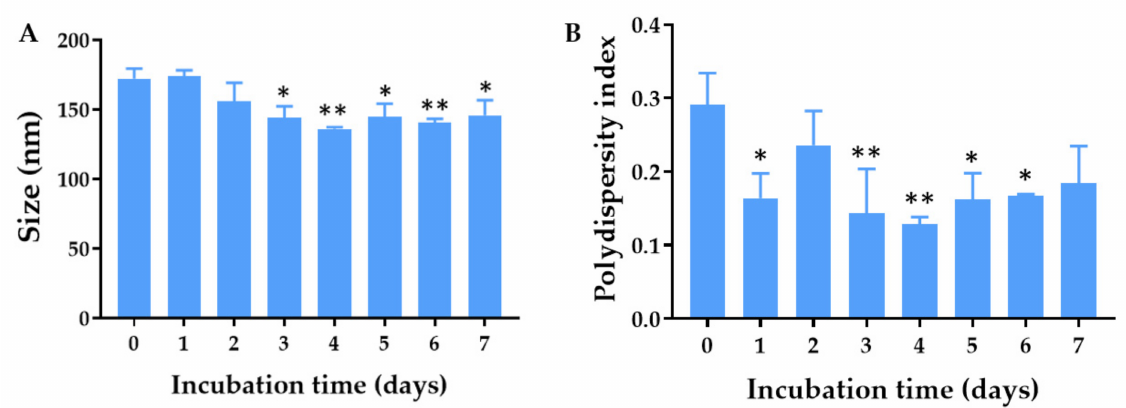
Figure 4. ( A ) Hydrodynamic diameter and ( B ) polydispersity index of the quercetin-loaded PLGA NPs after fresh prepara- tion and storage in phosphate buffer saline for 1, 2, 3, 4, 5, 6, and 7 days at 37 ◦ C. * and ** indicate p < 0.05 and 0.01 compared with day 0,